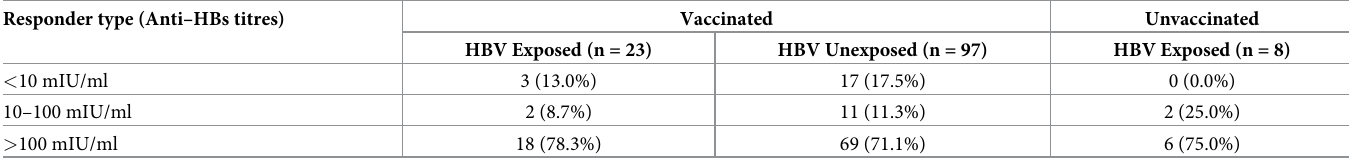
Table 3. Classification of immune responses based on anti-HBs titres, vaccination and HBV exposure status among HCW at KNH, Mbagathi County and Naivasha sub-county hospitals.